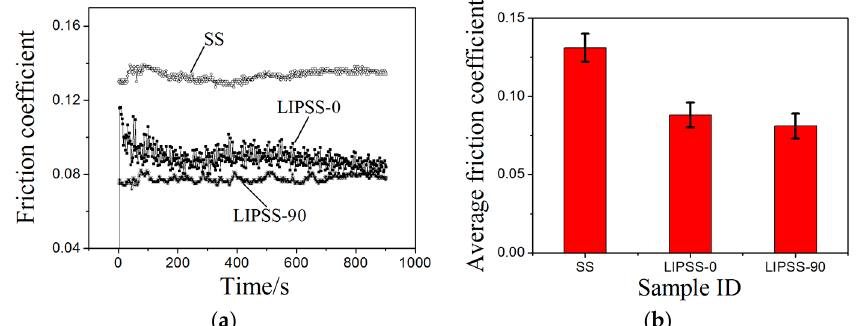
Figure 6. The results of friction test under the starved lubricated condition. ( a ) Variation of the friction coefficient with time; ( b ) Average friction coefficients.